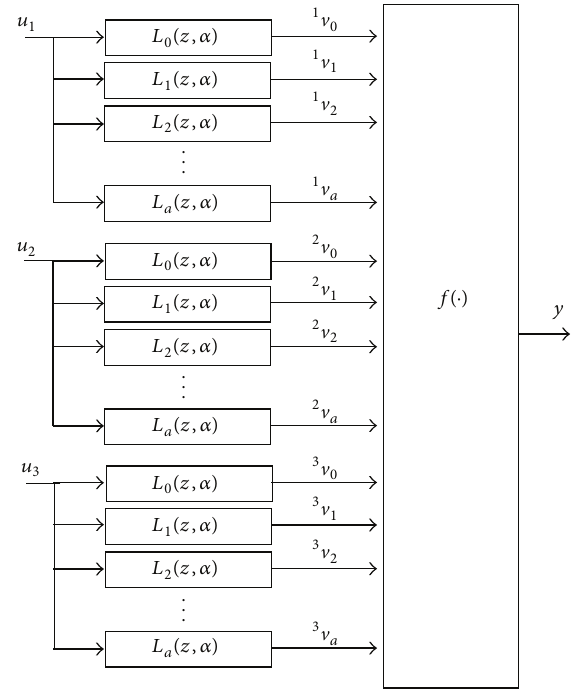
Figure 2: Wiener-Laguerre network